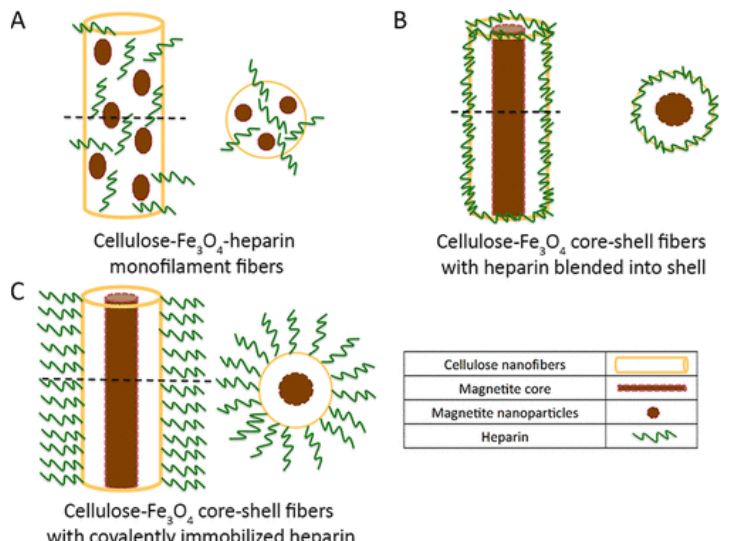
Figure 2. Structure of nanofibers. ( A ) Cellulose–Fe 3 O 4 –heparin monofilament fibers with entrapped Fe 3 O 4 NPs and heparin. ( B ) Cellulose–Fe 3 O 4 core–shell nanofiber with internal Fe 3 O 4 NP core and cellulose shell blended with heparin. ( C ) Cellulose–Fe 3 O 4 core–shell nanofiber with internal Fe 3 O 4 NP core and cellulose shell with covalently immobilized heparin. Reprinted with permission from [74]. Copyright 2016 American Chemical Society.